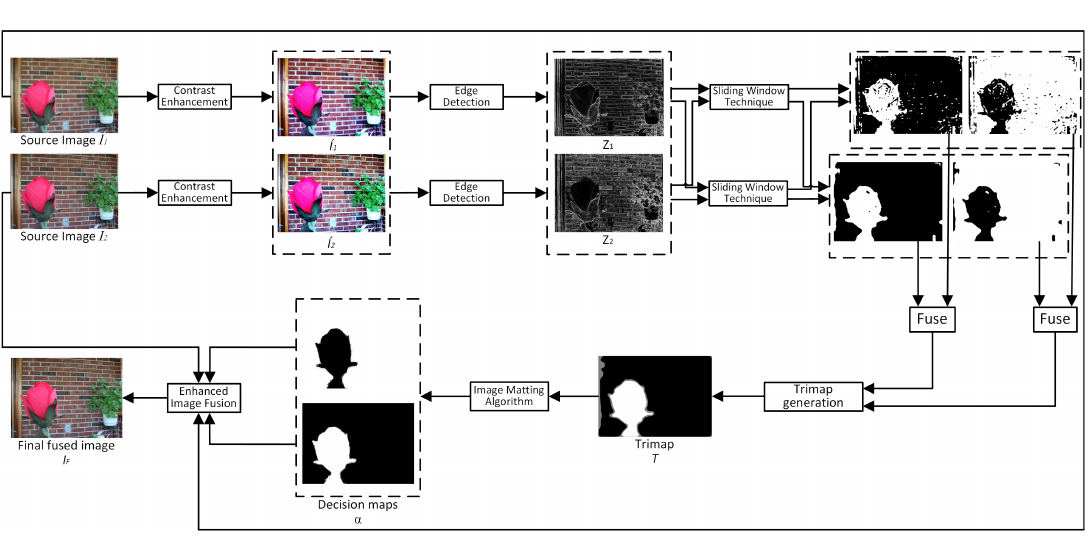
Figure 1. Schematic diagram of the proposed approach for the image fusion algorithm. Algorithm 1: Proposed MSIM based Fusion